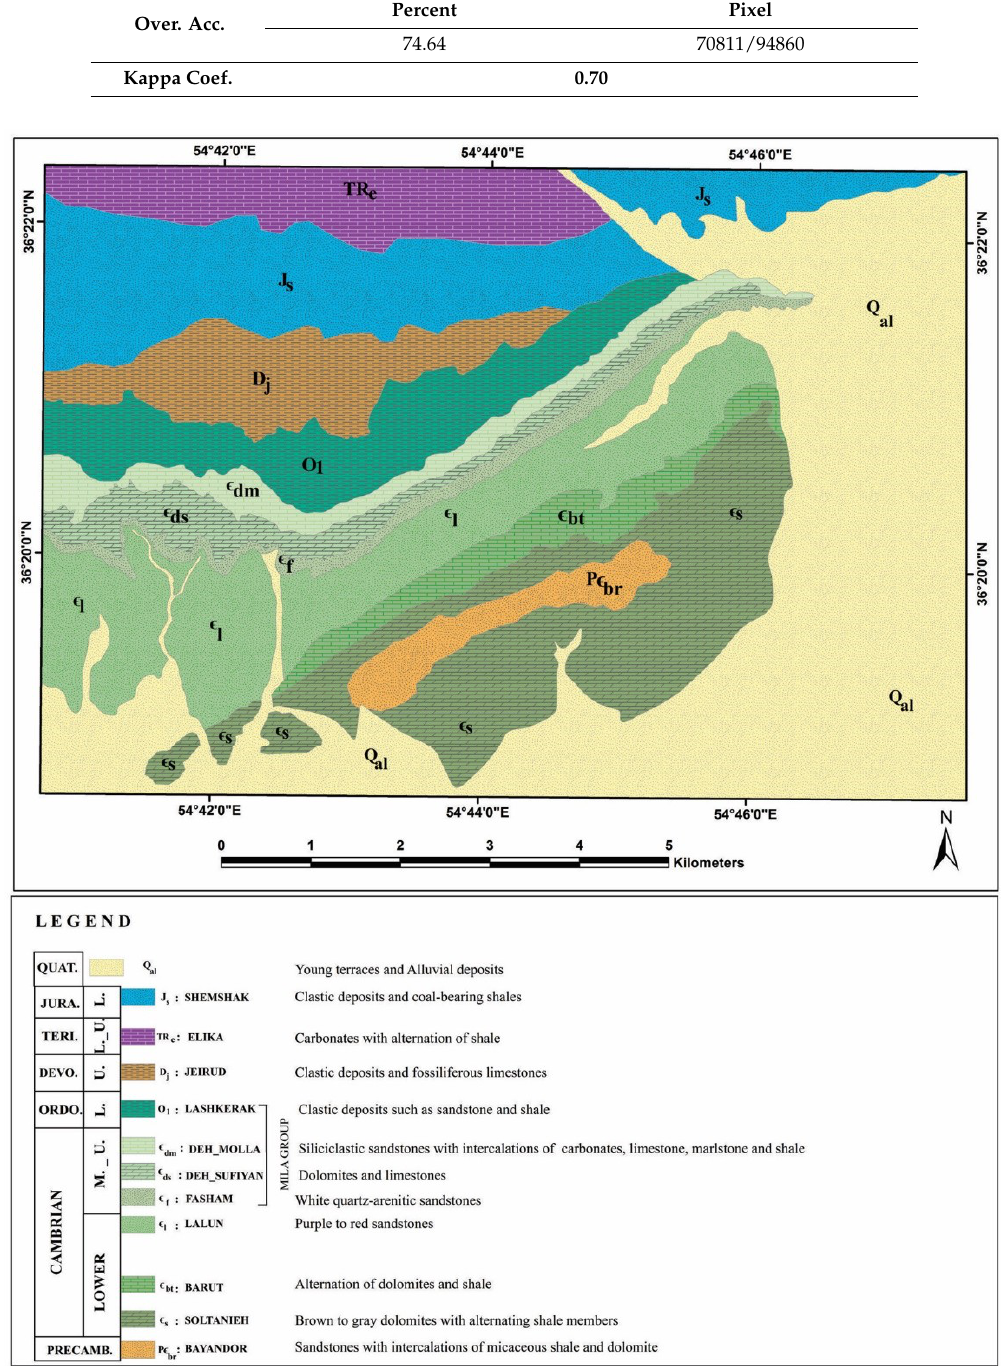
Figure 12. Geological map the Deh-Molla region derived from the BRMT approach.